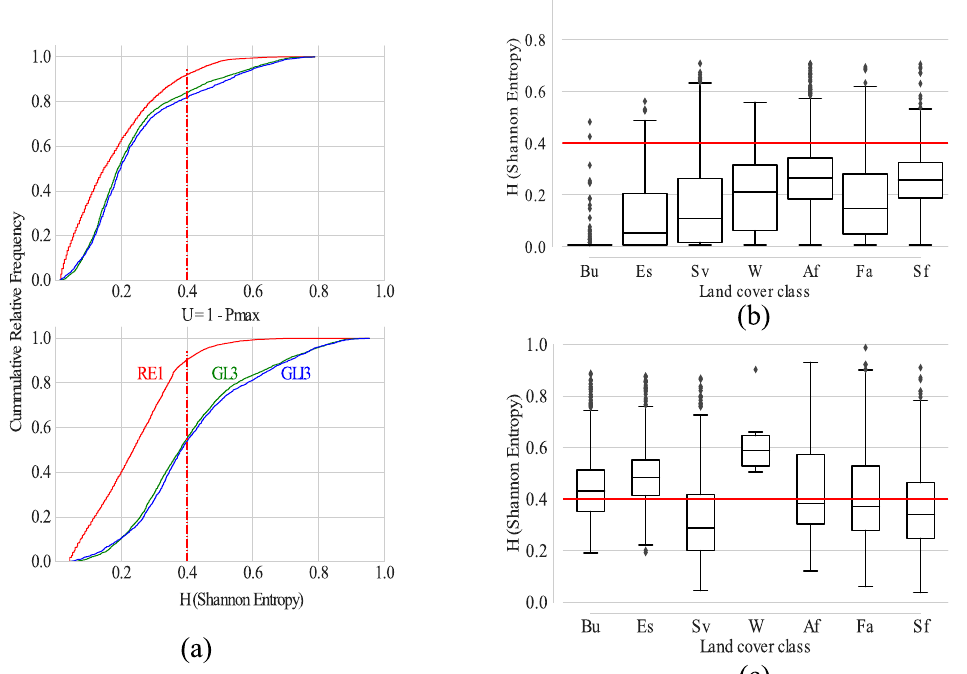
Figure 7. Classification uncertainties as a validation of the models with the highest accuracy. ( a ) The Shannon entropy ( H ) clearly reveals uncertainty in the classification accuracy’s validation. For the thematic maps from the RE1 and GL3 R models, and as an example, the proportion of pixels with uncertainty below 0.4; ( b ) the individual class uncertainty, ( H ), for the RE1 model; and ( c ) the class uncertainty, ( H ), for the GL3 model.